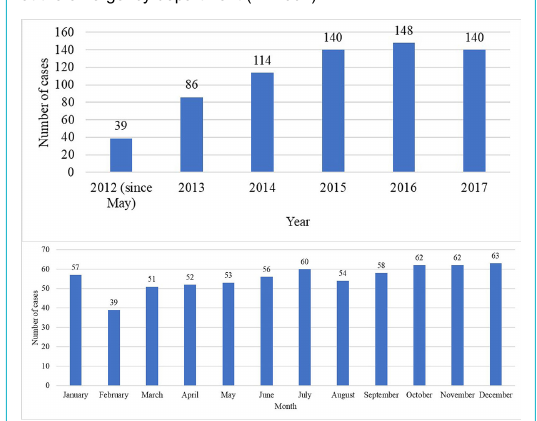
Figure 1: Annual (a) and monthly (b) distributions of the cases for which contact with the Poisons Information Centre was undertaken at the emergency department (N = 667).